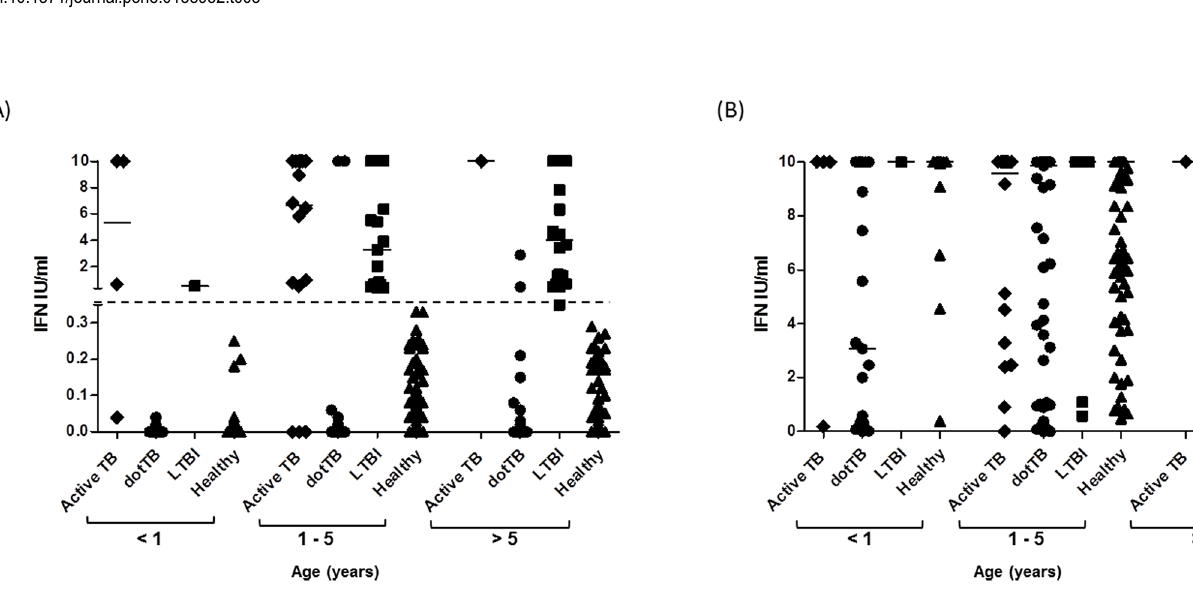
Fig 2. Quantitative response to QuantiFeron TB Gold-In Tube in relationship to age. IFN- γ levels in response to stimulation with M . tuberculosis antigens (A) and mitogen (B); individual QFT-IT results are plotted according to their final diagnosis and age. The cut-off value for a positive QFT-IT is represented by the dotted line at 0.35